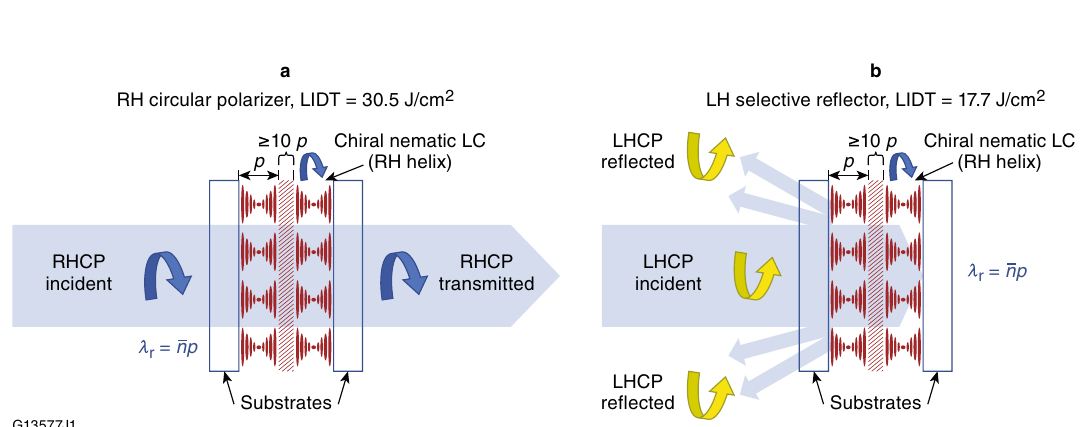
Figure 5. Propagation of right-handed circularly polarized (RHCP) and left-handed circularly polarized (LHCP) light through an LC device containing a chiral nematic LC doped with CB-15 as the chiral twisting agent. ( a ) incident circular polarized light with the same twist sense as the LC helix (RH) is transmitted, whereas in ( b ) for the same device, incident circular polarization of the opposite handedness (LH) is selectively reflected due to Bragg scattering. A cell thickness of at least ten pitch lengths ( p ), indicated by the area filled with diagonal slashes near the center of the cell, is required to observe these effects with sufficient magnitude for device